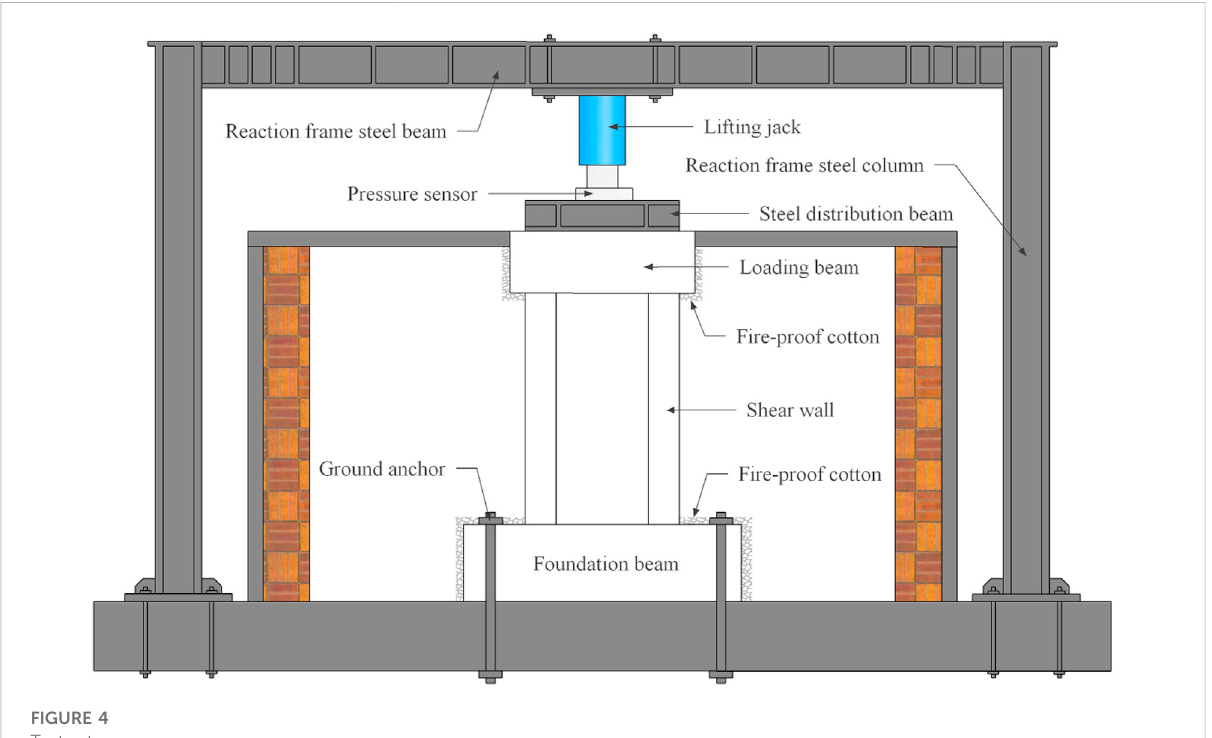
FIGURE 4 Test setup.